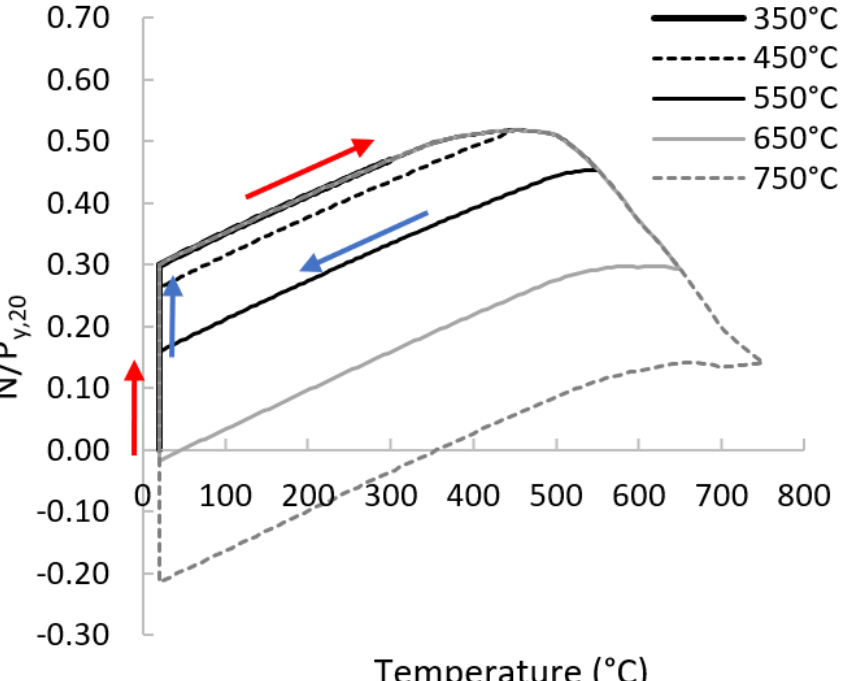
Figure 6. Axial forces in the HEB300_03 columns during heating and cooling.